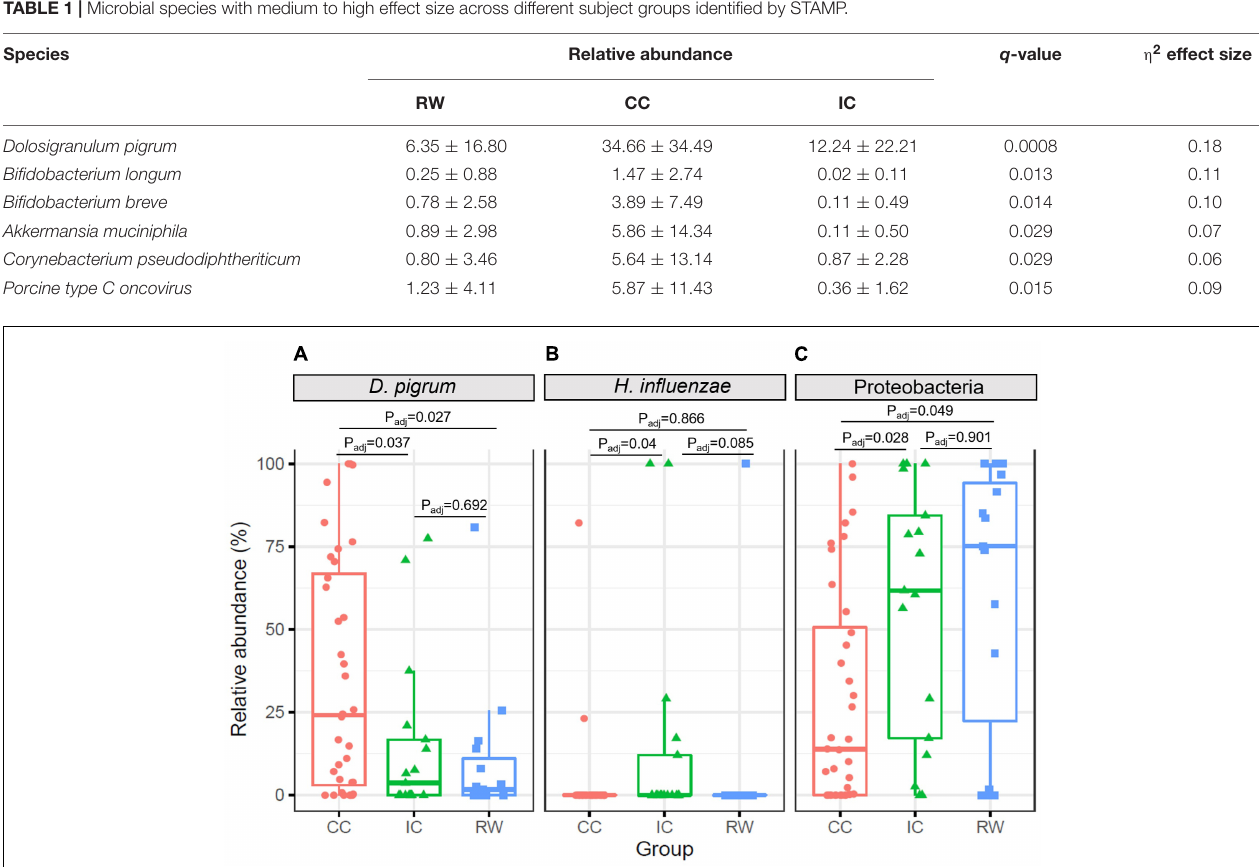
FIGURE 3 | Boxplots showing relative abundances of differentially abundant taxa at different taxonomic levels identified by ANCOM. (A) Left panel, D. pigrum species had higher abundance in CC group but lower abundance in IC and RW groups. (B) Middle panel, H. influenzae was more abundant in IC than CC group. (C) Right panel, Proteobacteria was more abundant in RW and IC than CC. CC, community control; IC, inpatient control; RW, recurrent wheeze.